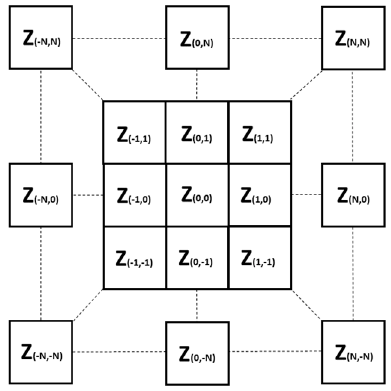
Figure 1. Image of the raster grid. Numbering system is shown. Z is the value of the raster. Notation is simplified. N = ( n − 1 ) /2 is used for any n × n analysis window, where n may be any odd integer smaller than the number of cells in the shortest side of the raster.